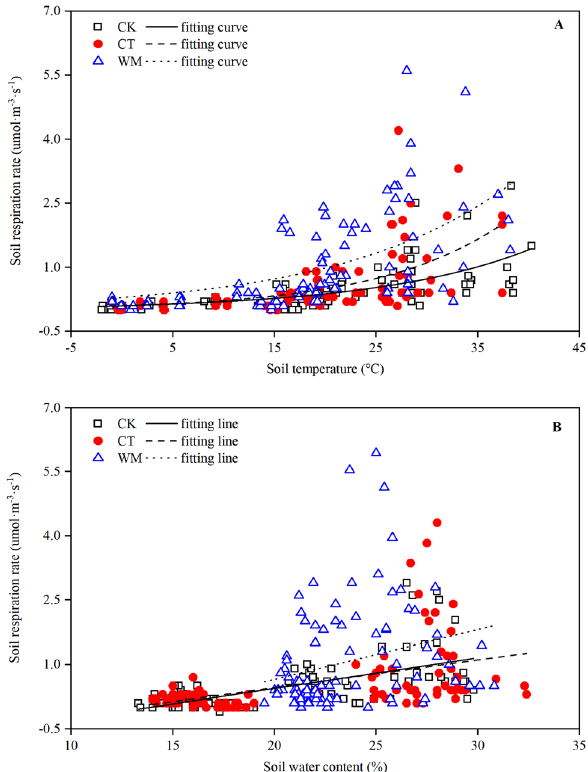
Figure 5. Relationships of daytime soil respiration to the soil temperature ( A ) and water content ( B ). Different types of lines are the linear fits in different months. CK, natural coastal wetland; CT, cotton mono-cropping farmland; and WM, wheat–maize rotation cropping farmland.